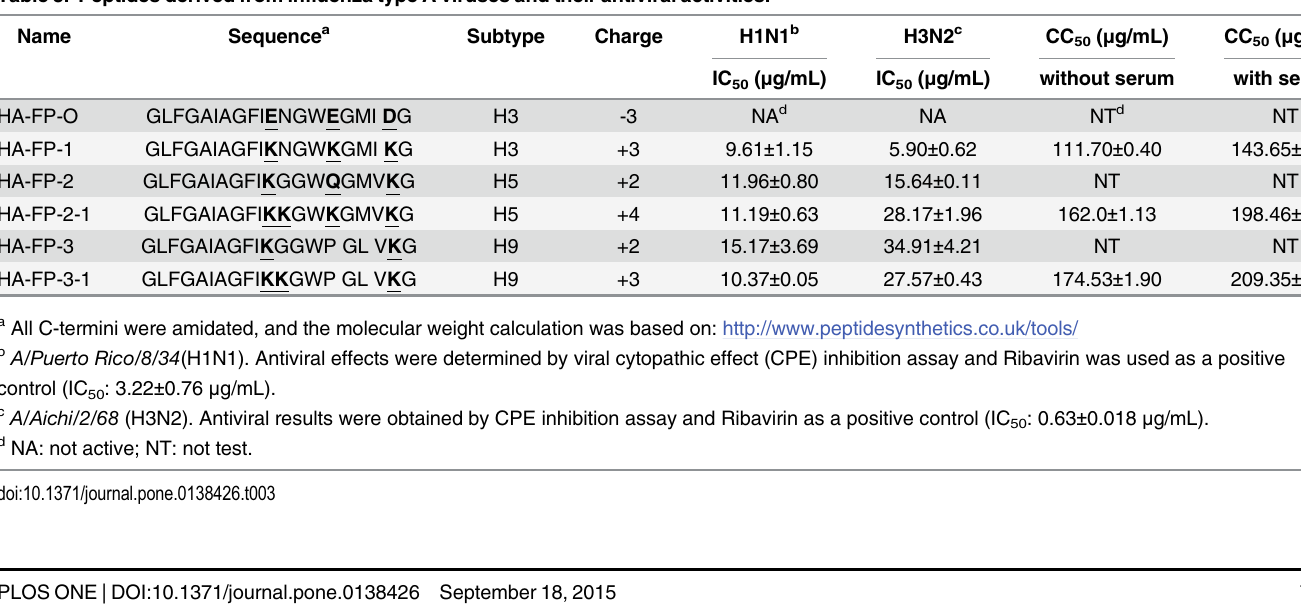
Table 3. Peptides derived from influenza type A viruses and their antiviral